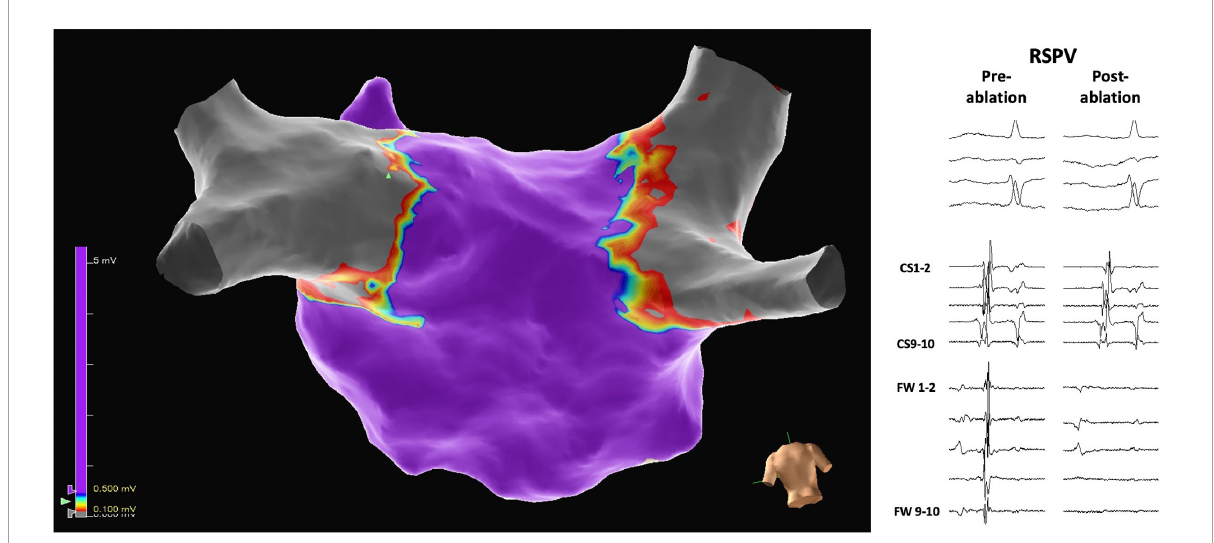
FIGURE2 Three-dimensional electrophysiological voltage maps after pulmonary vein isolation were performed with pulsed field ablation. On the right, pre-and post-ablation electrograms demonstrate the isolation of, in this case, the right superior pulmonary vein (RSPV). The scale of the electrograms shown is 100 mm/sec.